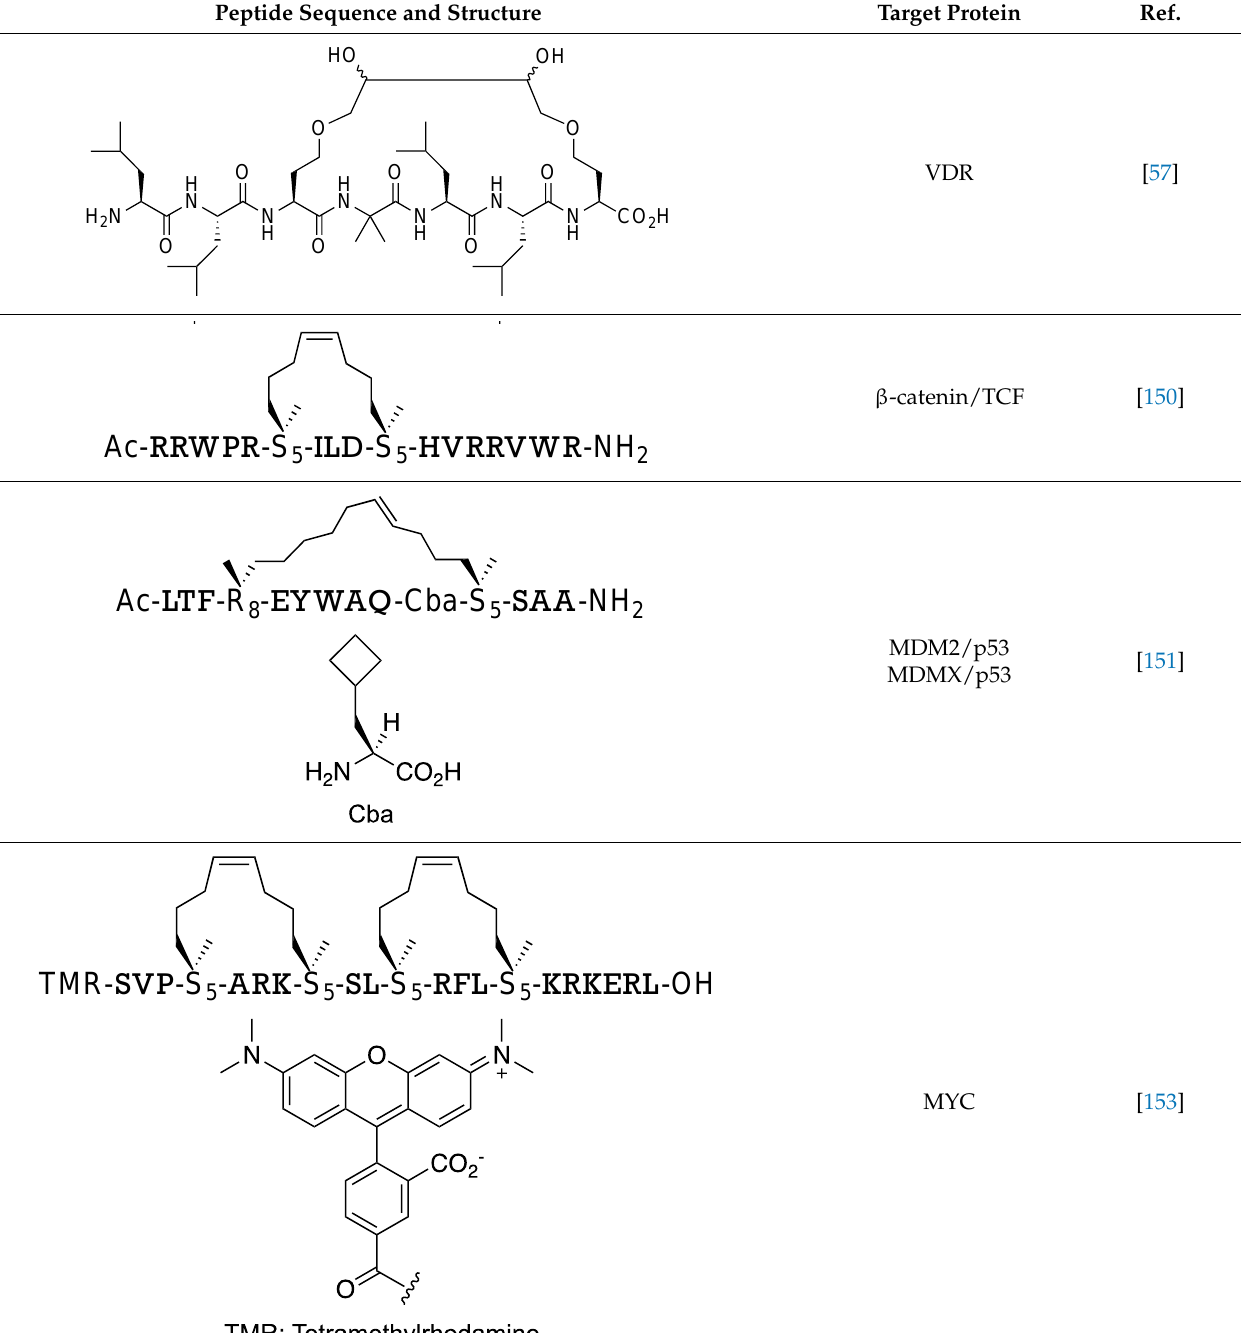
Table 7. Cont. Peptide Sequence and Structure Target Protein